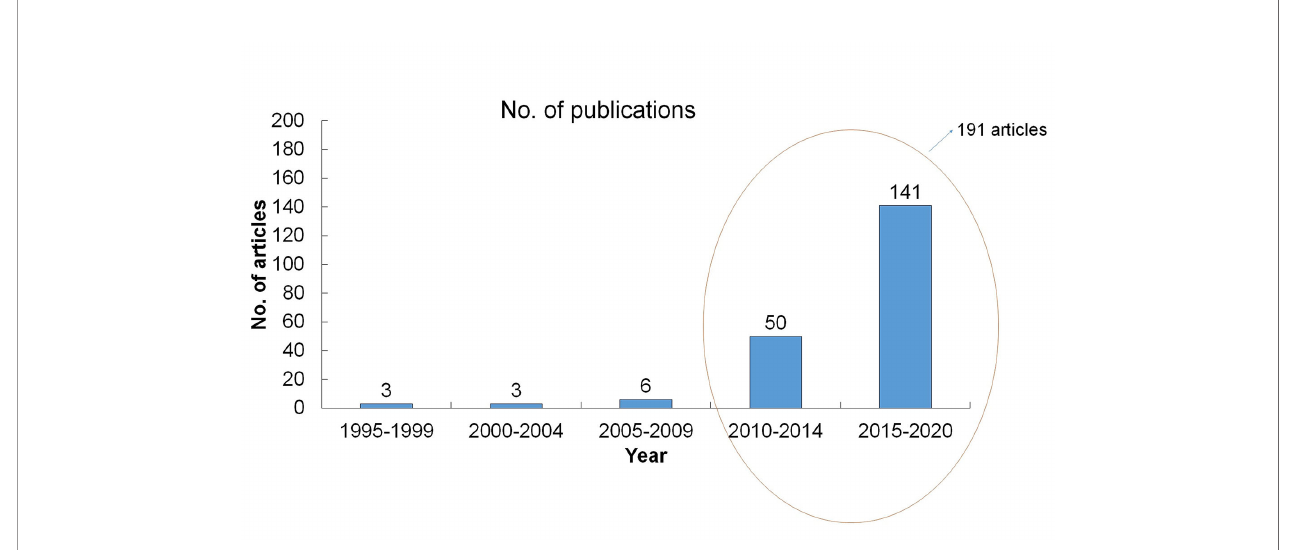
FIGURE 2 | A detailed list of publications on Terminalia sp. Till date. The information was collected from PubMed (https://pubmed.ncbi.nlm.nih.gov/?term=Terminalia +sp.& fi lter=ds1.y_10, 15 July